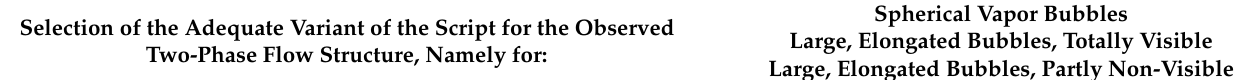
Table 1. Global scheme of the Matlab script functioning.